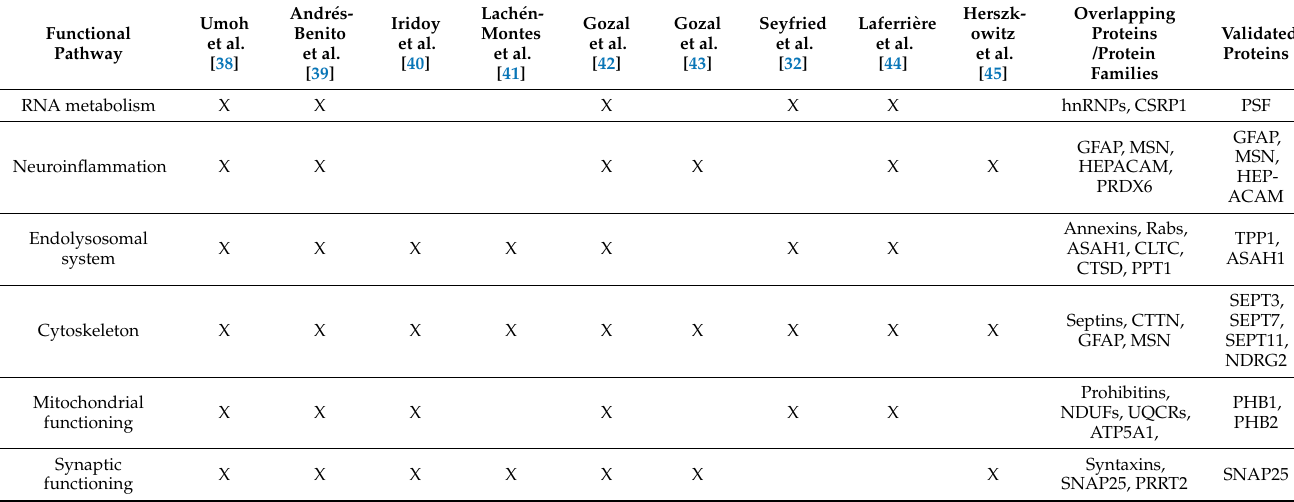
Table 2. Evidence for the involvement of functional pathways in FTLD-TDP following the different proteomic studies. The table indicates which studies reported proteins related to the six main pathways. Note that this overview is based on all proteins reported as significantly altered in FTLD-TDP, and does not always correspond to the pathways highlighted by individual studies (as shown in Table 1). The last two columns provide the major overlapping proteins and protein families, and candidate proteins of individual studies that were confirmed dysregulated in FTLD-TDP by additional validation experiments (e.g., immunoblotting, immunohistochemistry). The proteins of both columns combined are also depicted in Figure 1. A complete list of overlapping proteins can be found in Table S1. Functional